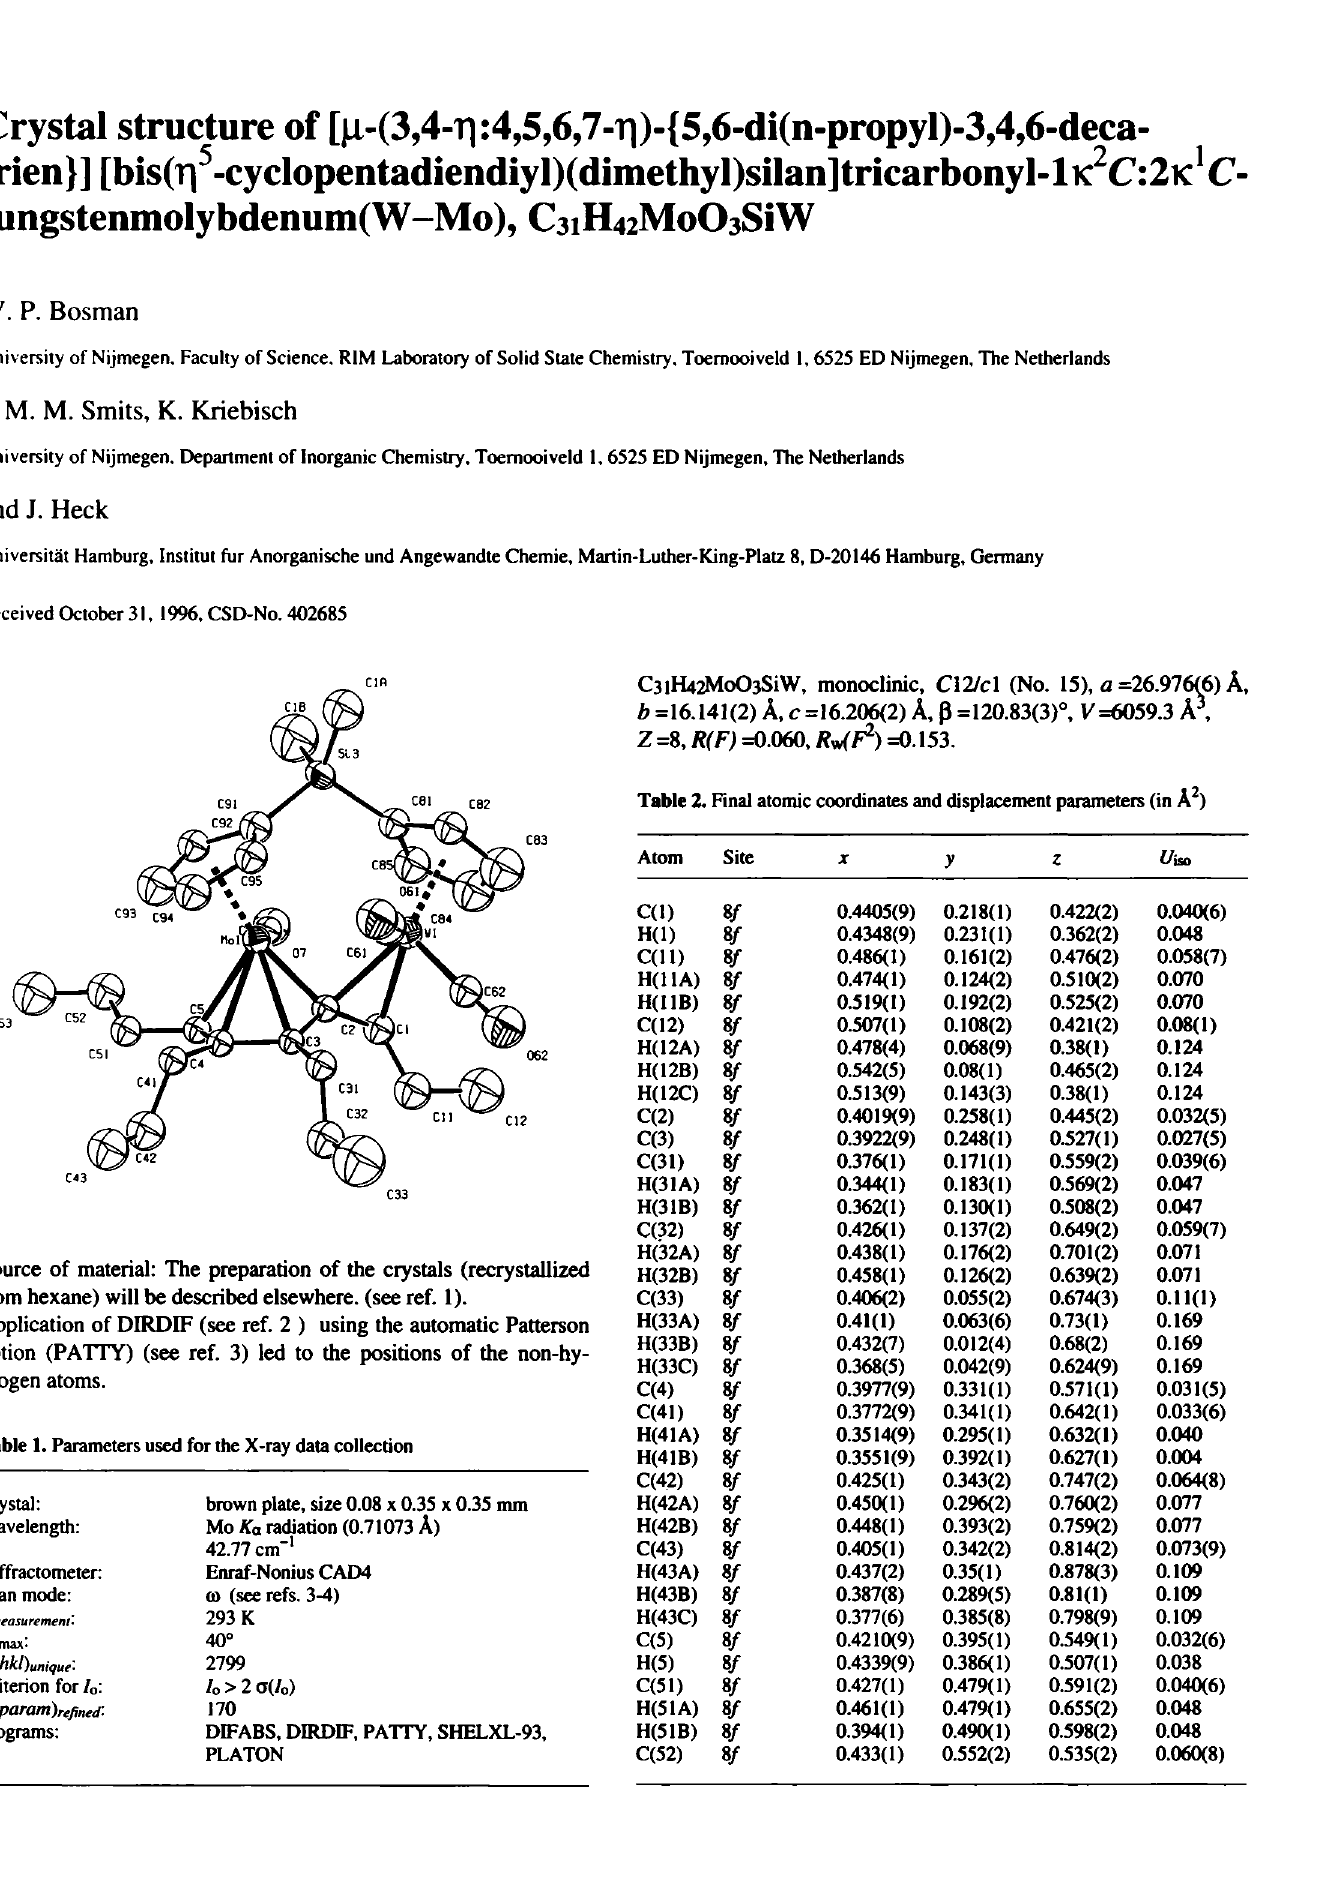
Table 1. Parameters used for the X-ray data collection Crystal: